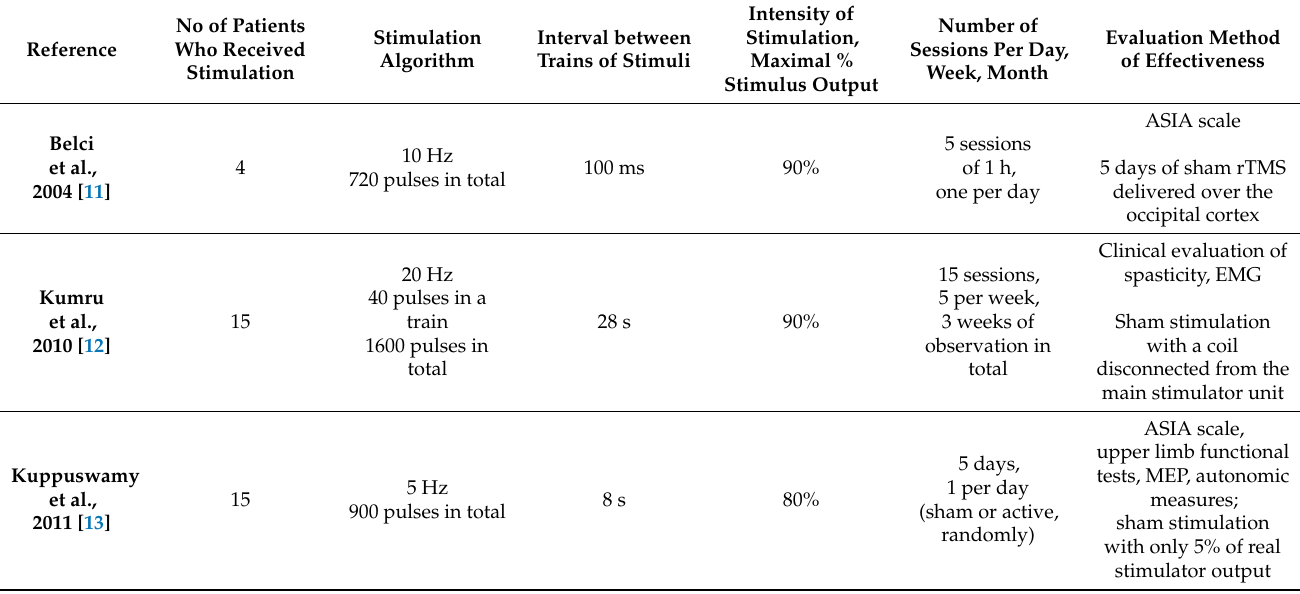
Table 4. Data on parameters of transcranial magnetic stimulation in patients with spinal cord injury were gathered from available literature and from observations where effects confirmed its